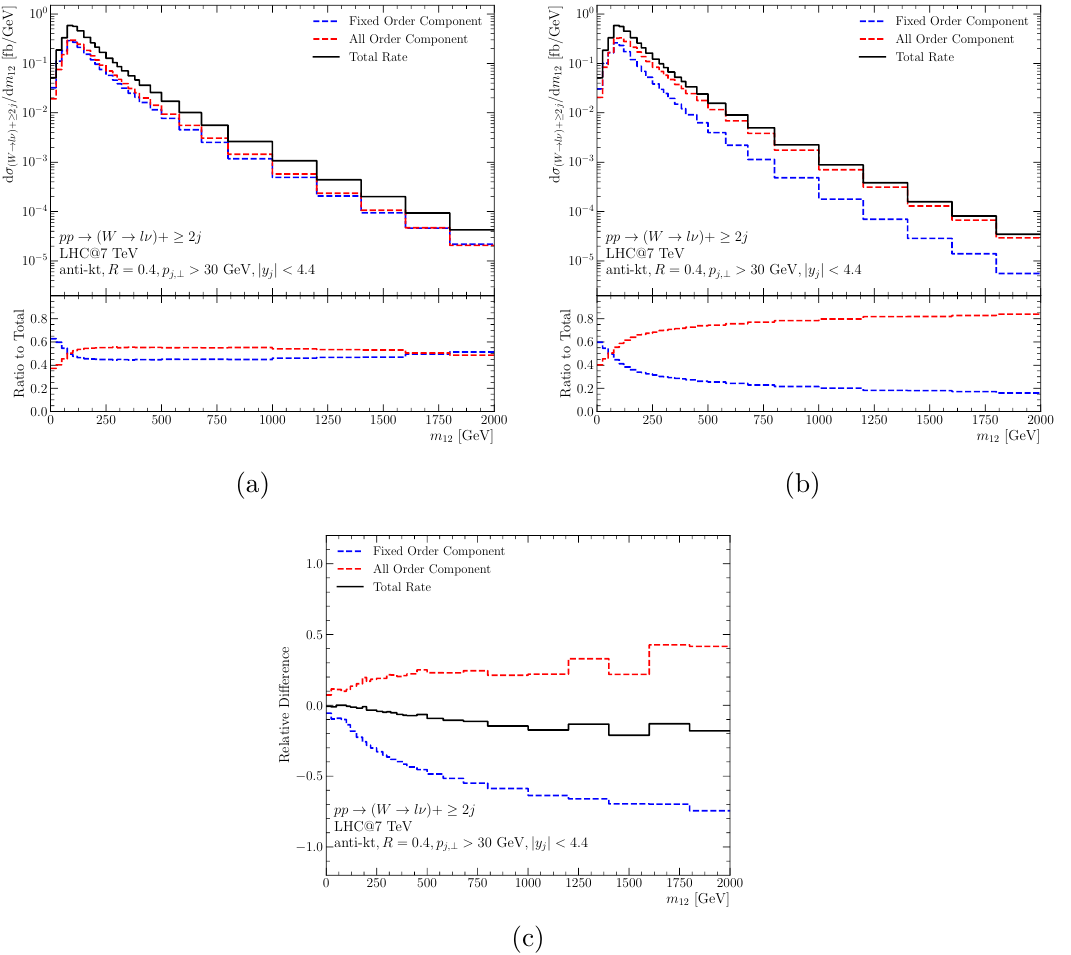
Figure 22. The differential distribution (black, solid) in the invariant mass of the two leading jets in pp → ( W → ‘ν ) ≥ 2 j , without and with resummation applied to NLL states. The panels and lines are as in figure